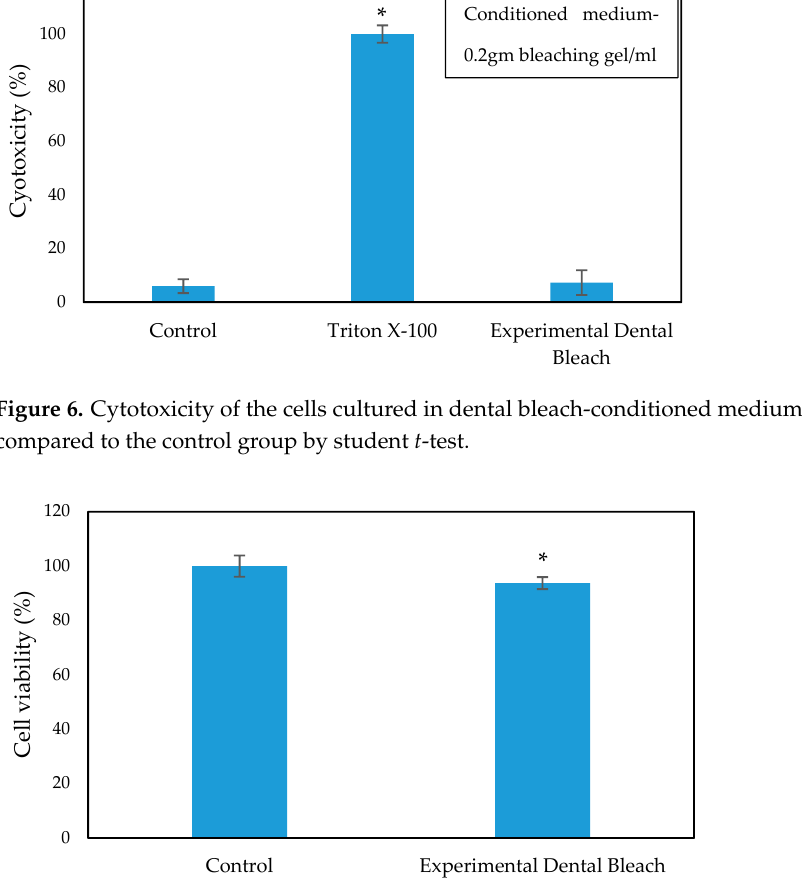
Figure 7. WST-1 assay for 3T3 cell viability evaluation on exposure to dental bleach-conditioned medium ( n = 6), * p < 0.05 compared to the control group by student t -test.